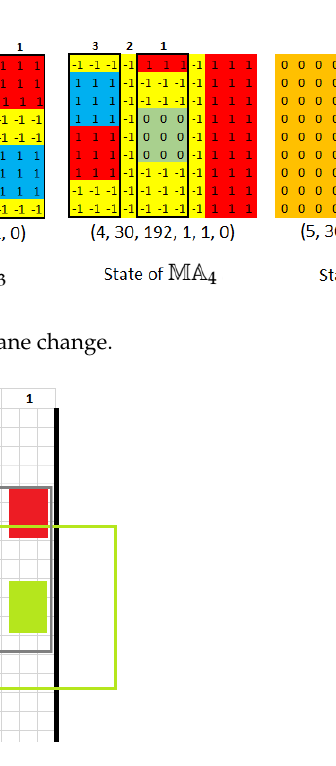
Figure 6. Complete situation in lanes with detection field of each vehicle.